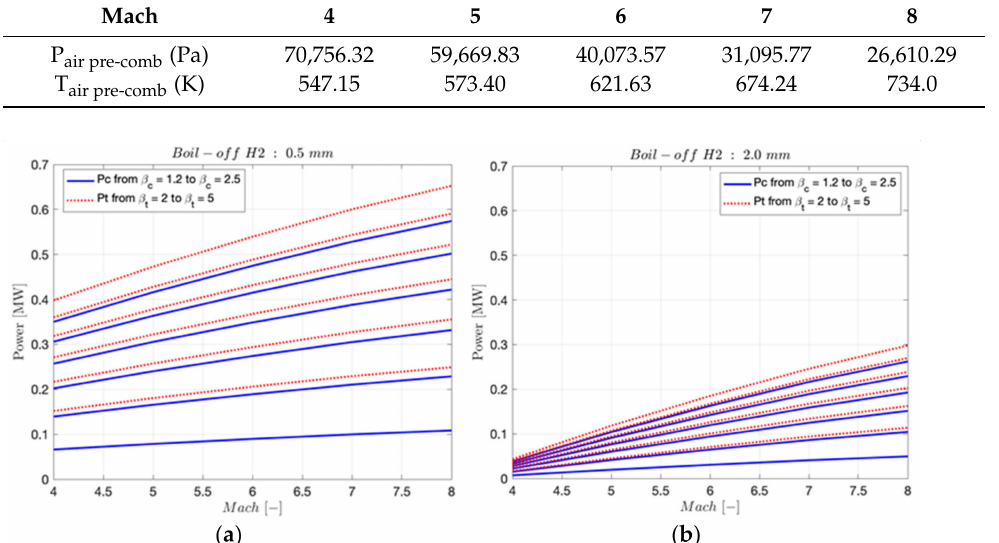
Figure 25. ( a ) Summary of internal and external heat loads acting on the cabin and estimated air convective insulation layer effect at Mach 4 flight condition; ( b ) summary of internal and exter- nal heat loads acting on the cabin and estimated air convective insulation layer effect at Mach 8 flight conditions. Table 5. Pressure and temperature levels at pre-combustion conditions for different Mach numbers.